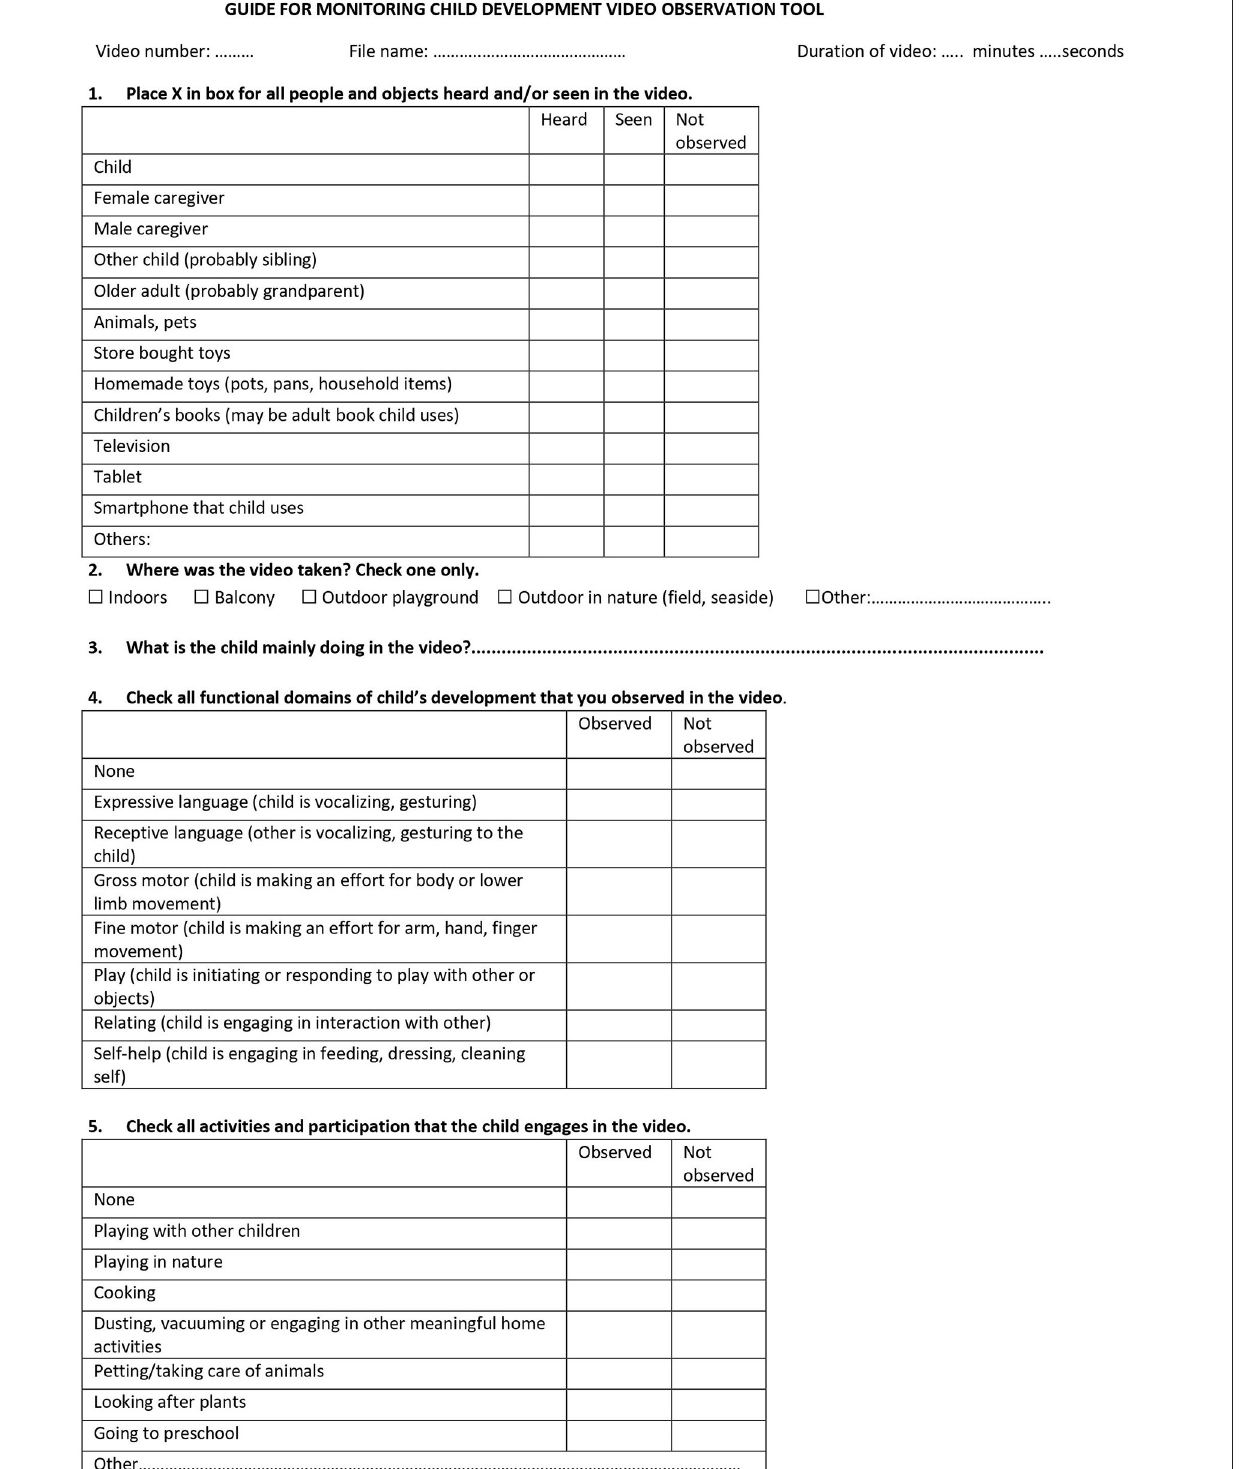
Frontiers in Pediatrics |